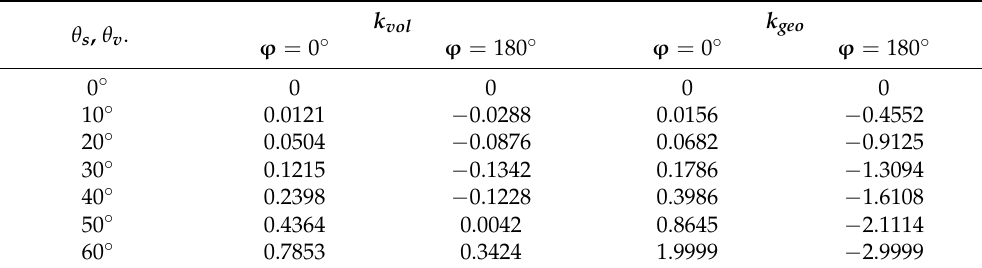
Table 2. k vol and k geo , corresponding to hotspot ( ϕ = 0 ◦ ) and darkspot ( ϕ = 180 ◦ ) , can be calculated against solar zenith angle (SZA) at an increment of 10 ◦